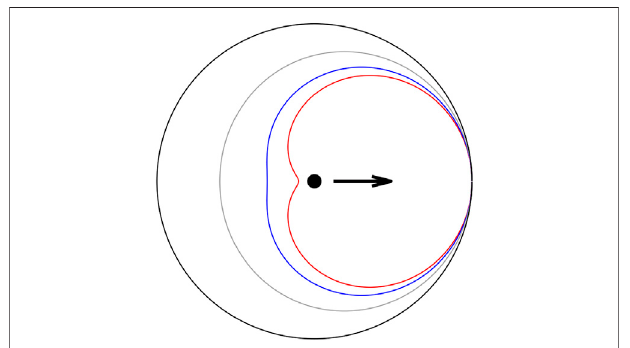
FIGURE 1 | Action area of the territorial effects for a pedestrian (black dot) moving totheright considering different λ α values: λ α (cid:2) 1(black), λ α (cid:2) 0 . 6 (gray), λ α (cid:2) 0 . 3 (blue), λ α (cid:2) 0 . 1 (red).